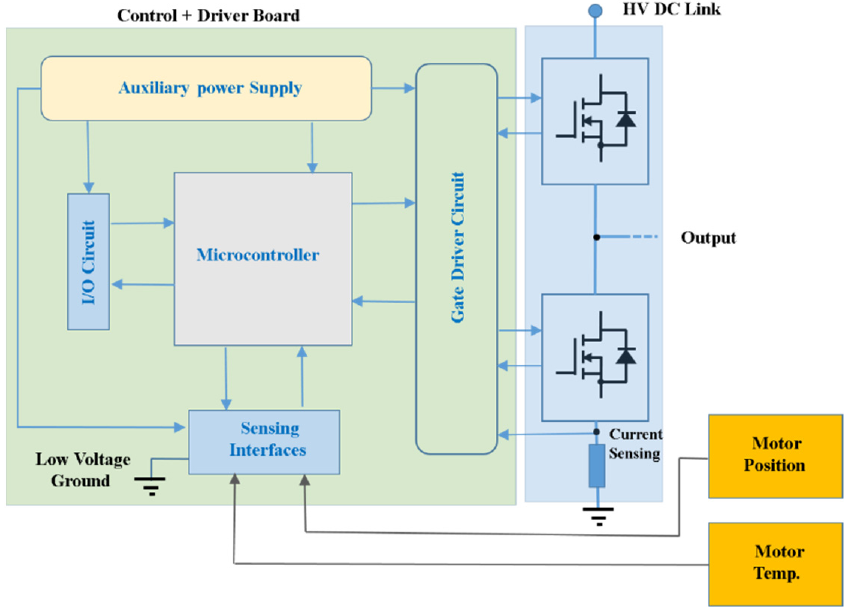
Figure 3. Half ‐ bridge power converter with the main low ‐ voltage electronic circuits that need Figure 3. Half-bridge power converter with the main low-voltage electronic circuits that need auxiliary power supplies. auxiliary power